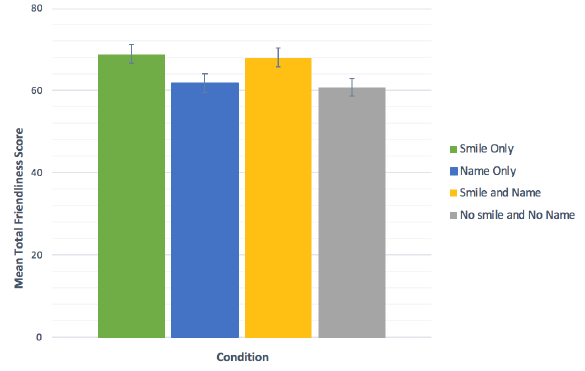
Figure 5: Effects of smiling and use of name on perceptions of robot friendliness. Note: error bars represent 1 Standard Deviation of